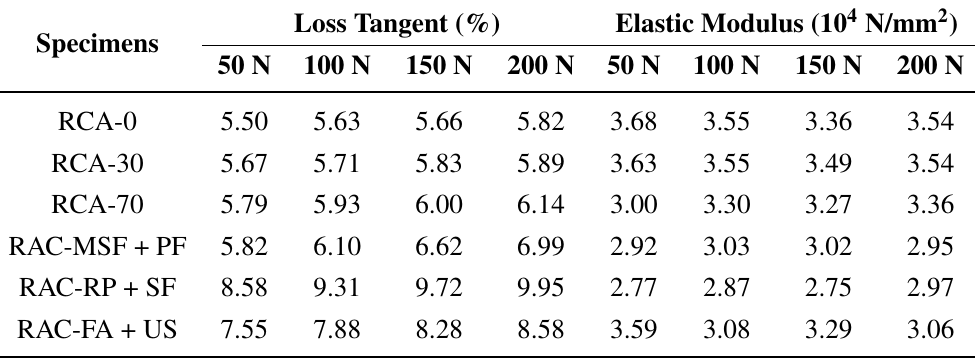
Table 7. The loss tangent and elastic modulus of recycled aggregate